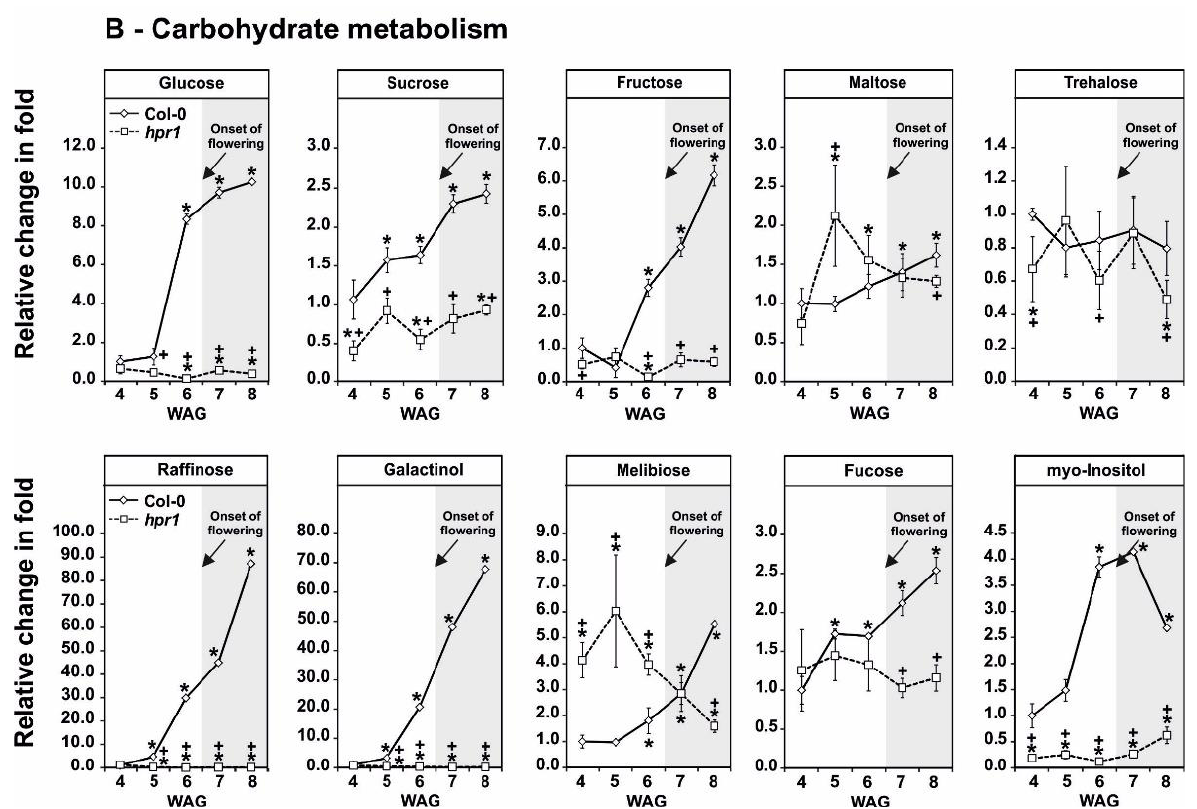
Figure 4. Metabolic acclimation patterns of photorespiration and carbohydrates during development. Relative metabolite abundances of selected intermediates of ( A ) photorespiration and ( B ) carbohydrate metabolism in Arabidopsis wild-type and hpr1 mutant plants during development (3–7 weeks after germination (WAG)). Plants were grown under controlled environmental conditions (390 ppm CO 2 , ~120 µ mol m -2 s -1 light intensity, 20/18 ◦ C day/night temperature, ~70% relative humidity) in a balanced photoperiod (12/12 h day/night cycle). Mutant-to-wild-type ratios ± SD (five biological replicates) are shown (relative amounts, arbitrary units mg − 1 fresh weight), with the mean wild-type value at 3 WAG arbitrarily set to 1 (wild type, solid line; hpr1 , dashed line). The white shaded part of the graph represents the vegetative phase, while grey shading the reproductive phase. Asterisks show significant changes compared to the wildtype at 3 WAG and plusses (* p < 0.05) between the wild type and the hpr1 mutant at the respective timepoint according to Student’s t -test (* p < 0.05).